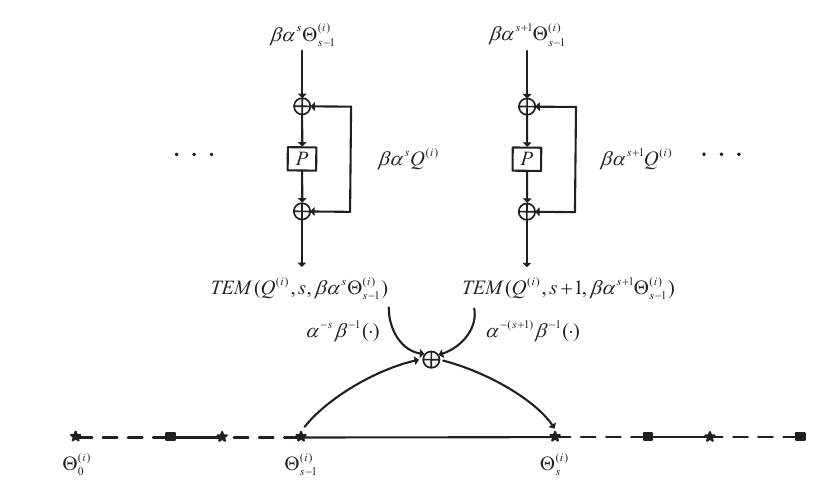
Figure 5: The Process of creating Θ ( i ) s on a Θ ( i ) chain with three distinguished